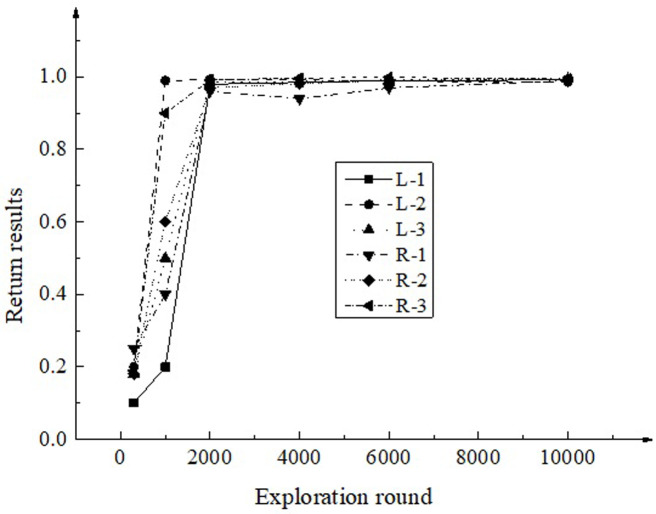
Performance test results of the base value network in H-DDPG algorithm under three scenarios (L- represents the action state to the left, R- to the right, and 1, 2, and 3 denote scenario 1, 2, and 3, respectively).